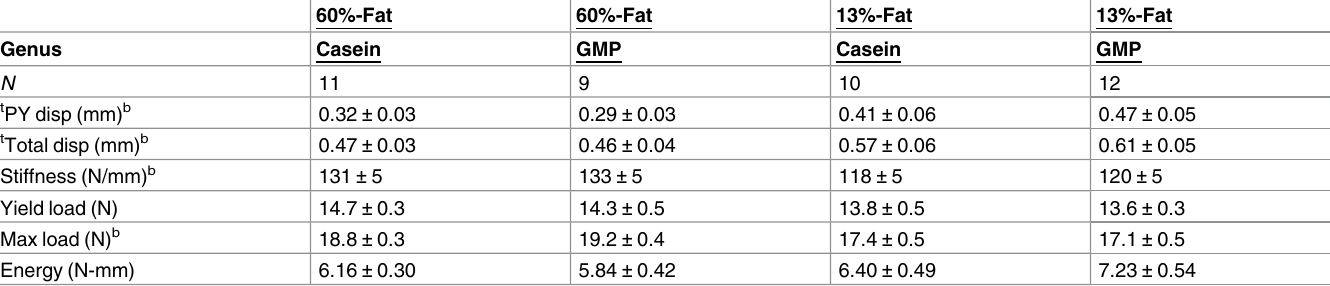
Table 3. Force-displacement Curve Analysis showing whole bone biomechanical performance of